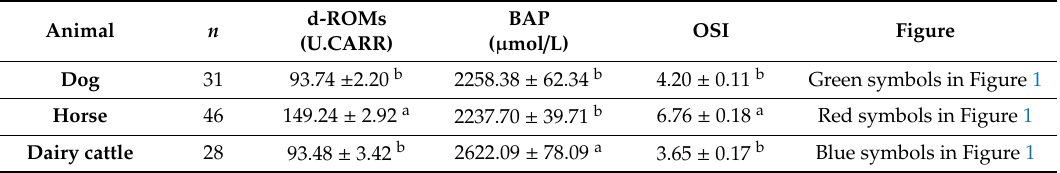
Table 2. d-ROM and BAP levels in animal sera and oxidative stress index